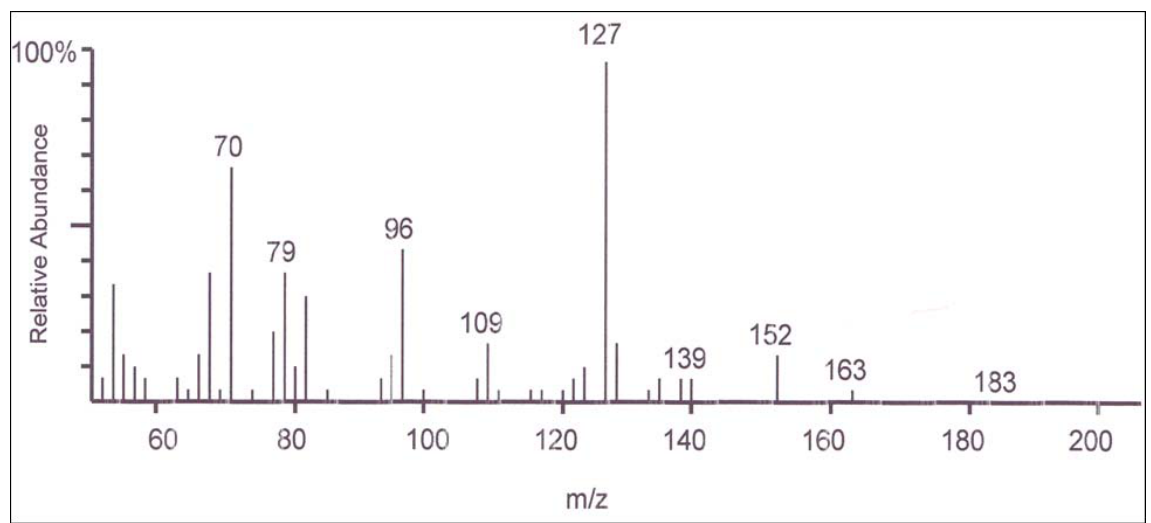
Figure 3. Mass spectra of cantharidinimide with base peaks at m/z 70, 96 and 127 according to a Hewlett-Packard gas